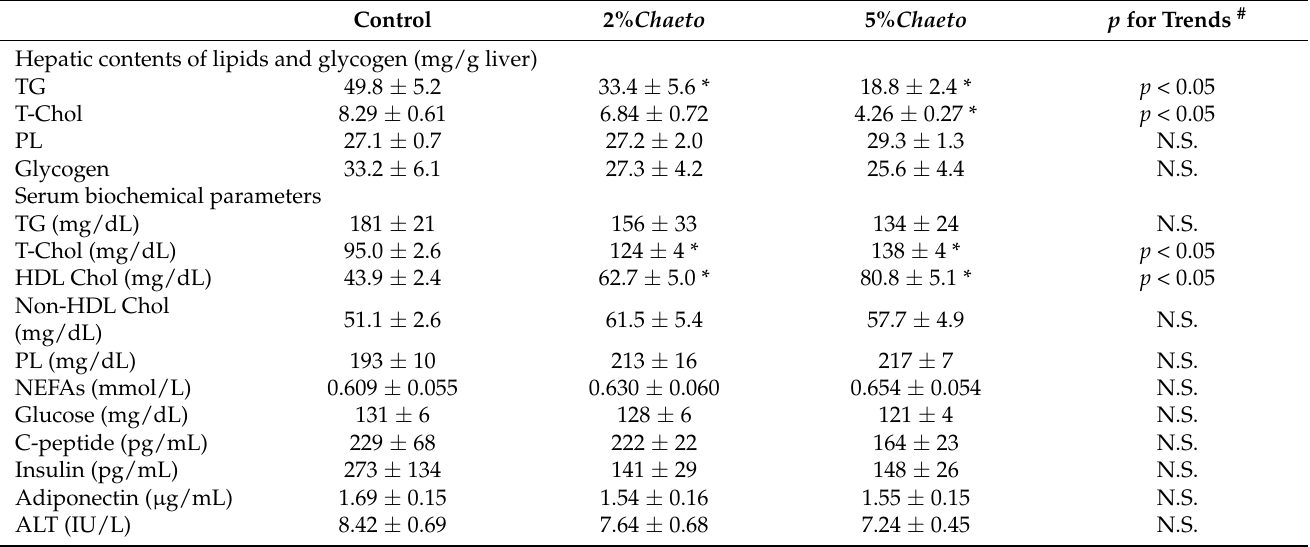
Table 4. Effects of C. gracilis feeding on hepatic lipid and glycogen contents and serum